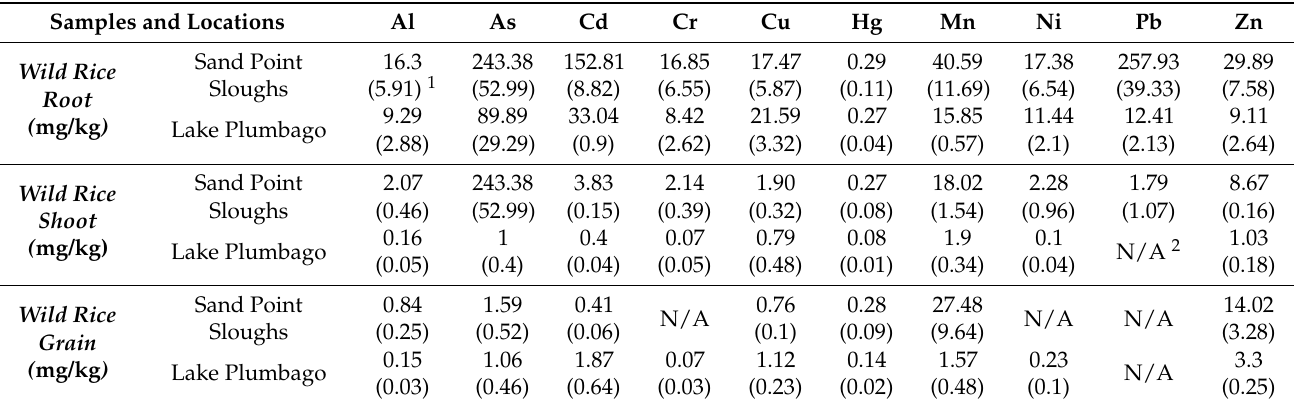
Figure 3. Total element concentrations in Sand Point sloughs and Lake Plumbago sediment, porewa- ter, and plant samples. The concentrations are expressed as mg/kg for sediment and plant samples and mg/L in water samples. ( A ). Copper, ( B ). Zinc. Data are reported as mean ± S.D. ( n = 3). Table 2. Bioconcentration factor of toxic elements in various parts of wild rice plants from Sand Point sloughs and Lake